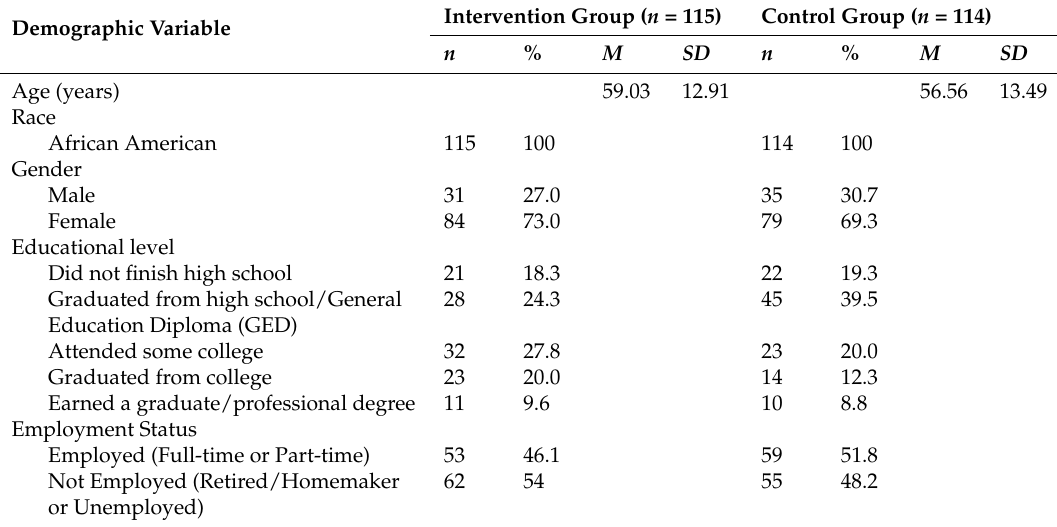
Table 1. Sociodemographic characteristics of the